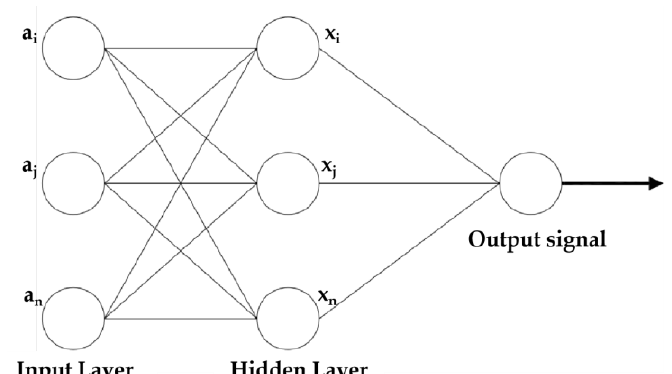
Figure 4. Artificial neural network structure.